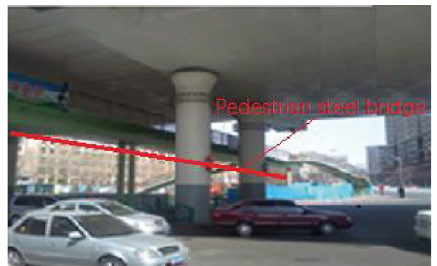
Figure 1: Urumqi Xingfu Road pedestrian bridge.